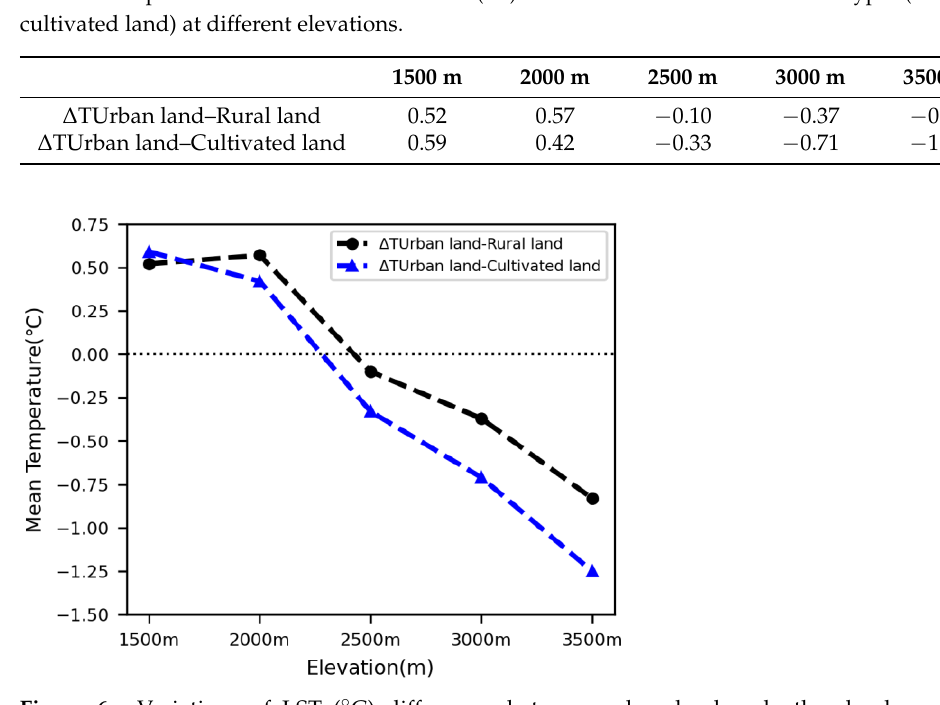
Table 4. Temperature differences between LST ( ◦ C) of urban land and other land use types (rural and cultivated land) at different elevations.